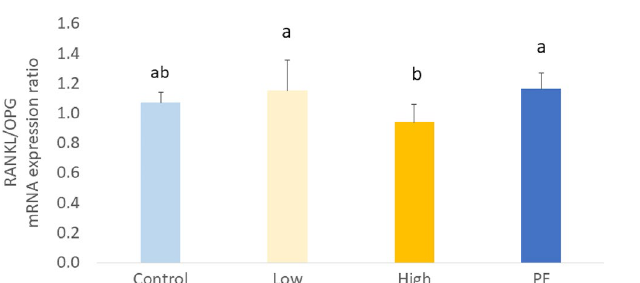
Figure 5. mRNA expression ratio of RANKL / OPG in bone marrow. Higher rate of RANKL / OPG indicated bone remodeling status. a,ab,b Treatments with different letters means a significantly difference between treatments by using Tukey’s HSD test, P = 0.005, N = 10. Control, non-challenge control group; Low, the low challenge dose of Eimeria ; High, the high challenge dosage of Eimeria; PF, pair-feeding group that paired with High